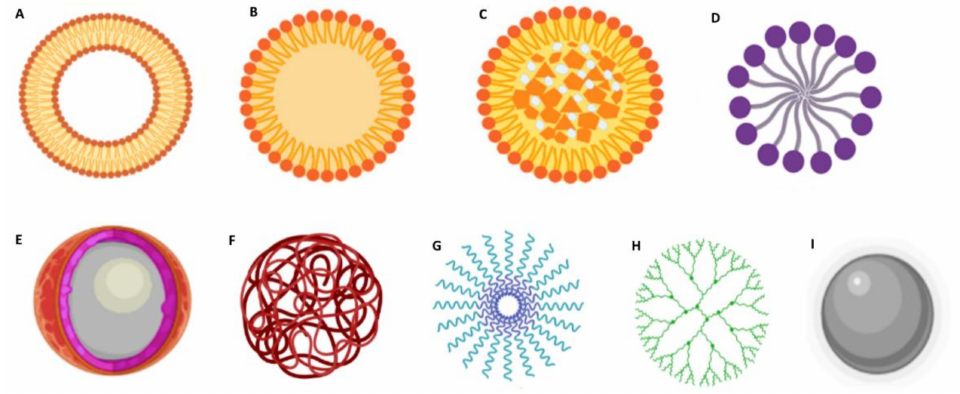
Figure 3. Schematic representation of different types of NPs used in biomedical applications. ( A ) liposome; ( B ) solid lipid NPs; ( C ) nanostructured lipid carriers; ( D ) lipid micelles; ( E ) poly- meric nanocapsules; ( F ) polymeric nanospheres; ( G ) polymeric micelles; ( H ) dendrimers; and ( I ) metallic